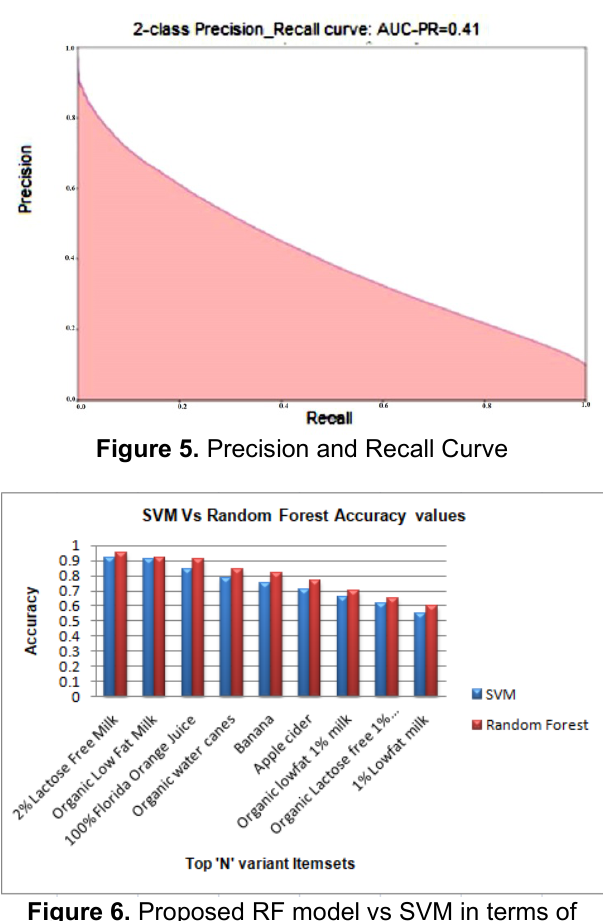
Figure 5. Precision and Recall Curve